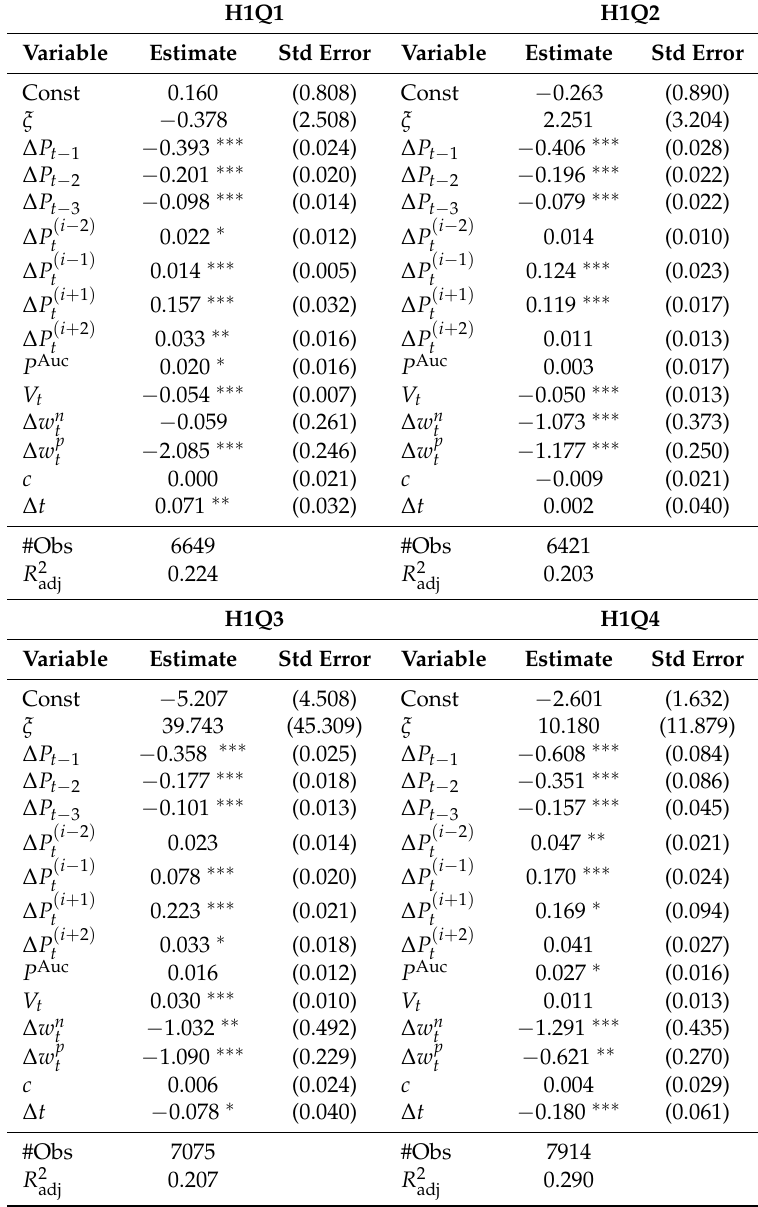
Table 2. Estimation results of the econometric model (1) for intraday price changes ∆ P t of 15-min. contracts